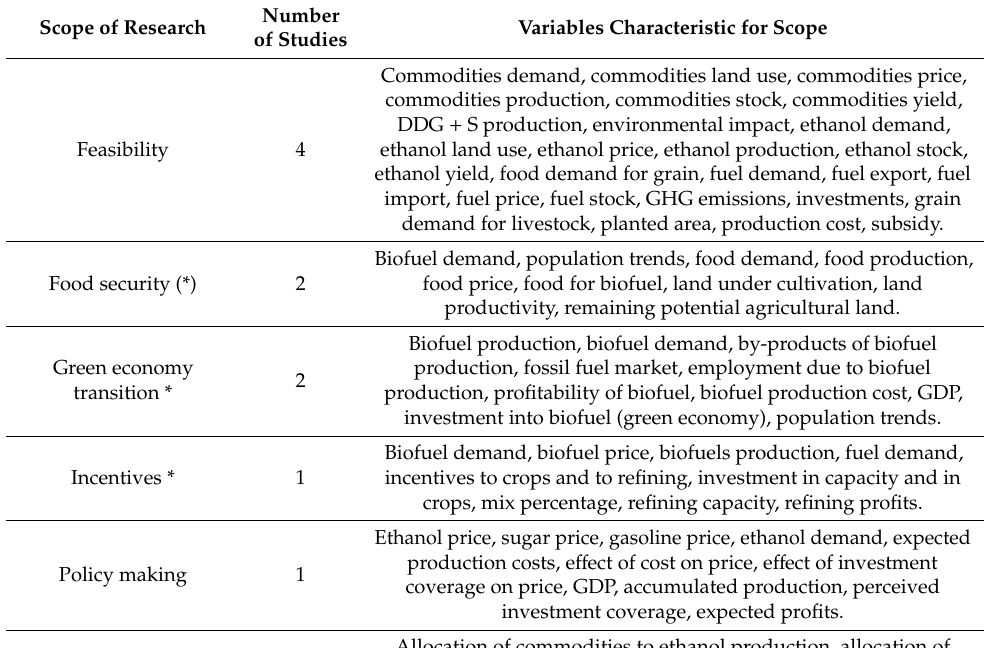
Table 1. List of input variables according to the scopes of the